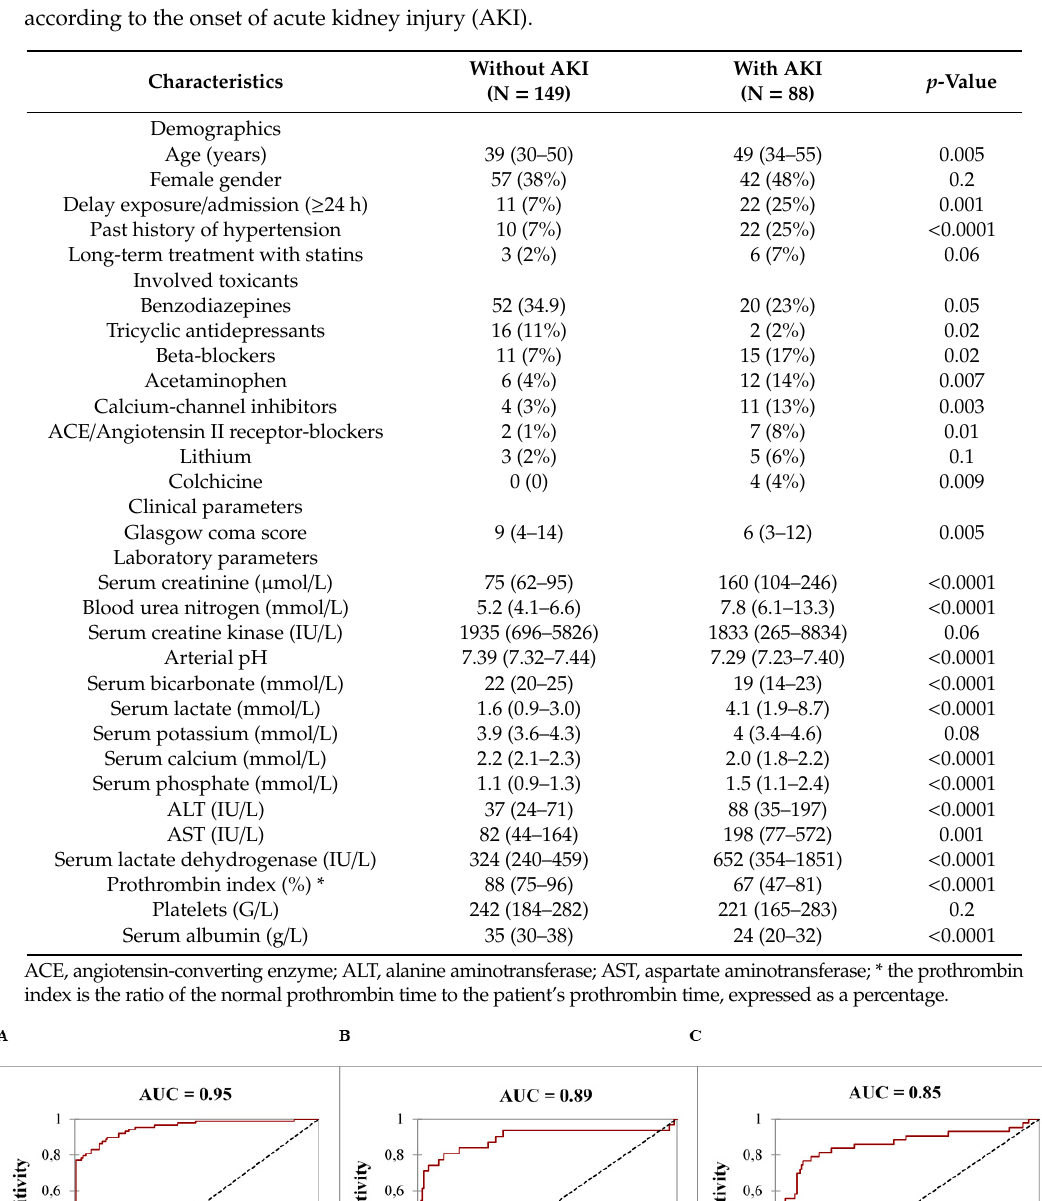
Figure 3. ROC curve of the different predictive models of acute kidney injury onset ( A ), renal replacement therapy requirement ( B ) and death ( C ) in the poisoned patients who developed rhabdomyolysis. 3.4. RTT Requirement Forty-three patients (49% of those who developed AKI, 18% of those who developed rhabdomyolysis) required RRT including hemodialysis (N = 29) and veno-venous continuous hemodiafiltration (N = 14). RTT was initiated 2 days (1–3) after ICU admission. Based on univariate comparisons, the variables significantly associated with RRT requirement are summarized in Table 6. Using a multivariate logistic regression analysis (Table 7), calcium-channel blocker overdose (OR, 14.2; CI, 3.8–53.6), serum phosphate ≥ 2.3 mmol/L (OR, 1.6; CI, 1.1–2.6), Glasgow coma score ≤ 5 (OR, 1.12; CI, 1.02–1.25), serum creatinine ≥ 125 µmol/L (OR, 1.01; CI, 1.00–1.01) and prothrombin index ≤ 71% (OR, 1.03; CI, 1.01–1.05) were the independent variables on ICU admission significantly associated with RRT requirement. The performance of our predictive model was supported by a ROC curve AUC of 0.89 (Figure 3B). Prothombin index ≤ 71% was the variable with the highest predictive value (AUC = 0.76) and sensitivity (0.70) for RRT. Serum phosphate ≥ 2.3 mmol/L was the variable with the highest specificity (0.95).